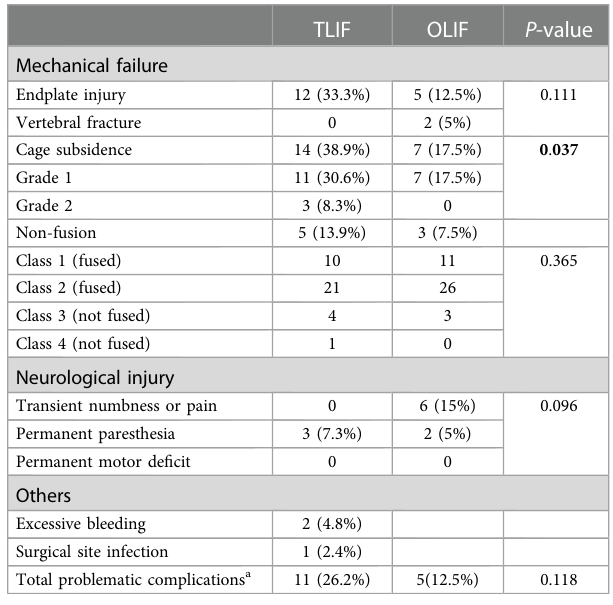
TABLE 5 Fusion status and total complications at 2-year